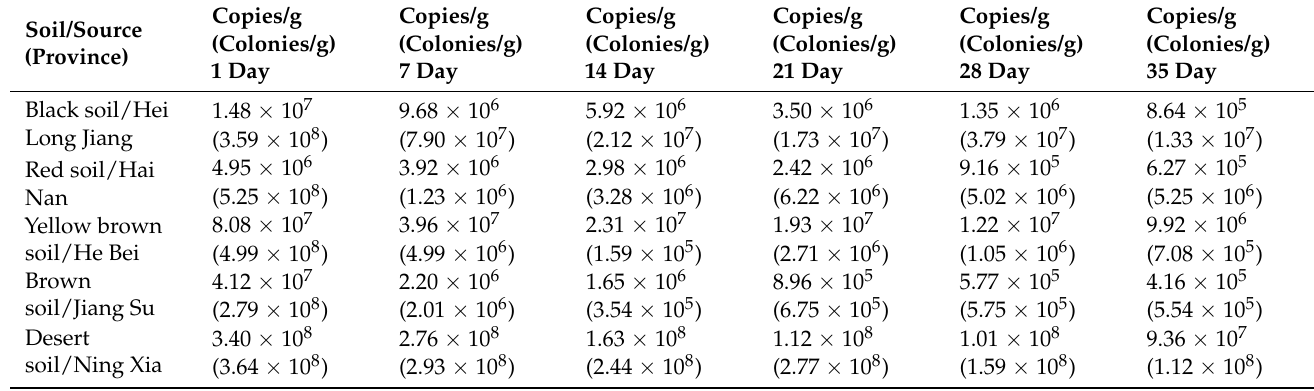
Table 3. Real-time PCR and plating assay detection of strain ZF2 in different soil types.